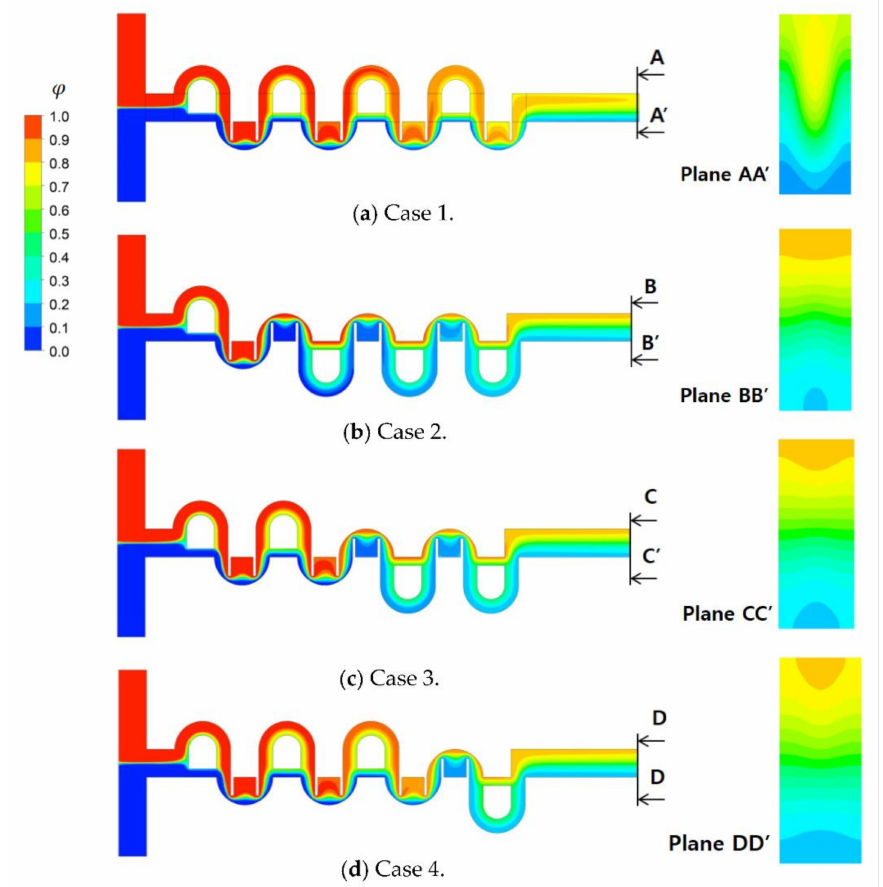
Figure 19. Comparison of the mass concentration distribution of the four cases for Re =